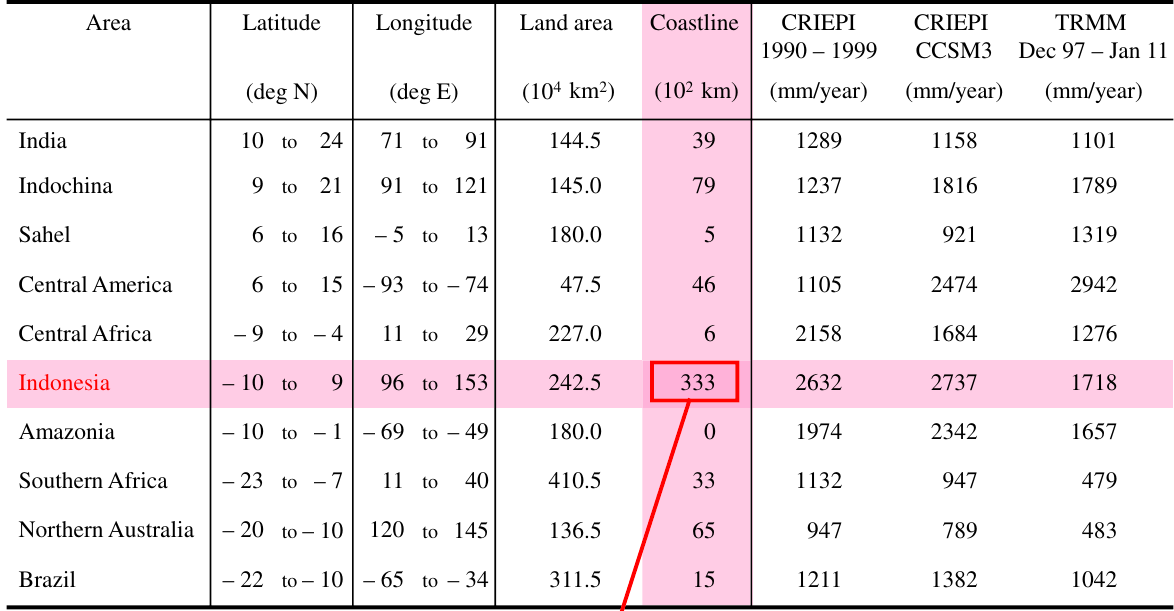
Table 1 Ten tropical regions specified in a basic study by the CRIEPI group (Maruyama et al. 2005) to check the reliability of a numerical climate model (CCSM3; Collins et al. 2006). Land areas and coastline lengths were estimated by calculating numbers of 1° longitude × 1° latitude (corresponding to 111 km × 111 km on the equator) grid points close to coastlines (within 0.5°). “ IPCC07 Obs/Model ” rainfall amounts are obtained from figures of the original paper. “ TRMM Dec97 − Jan11 ” is from Ogino et al.